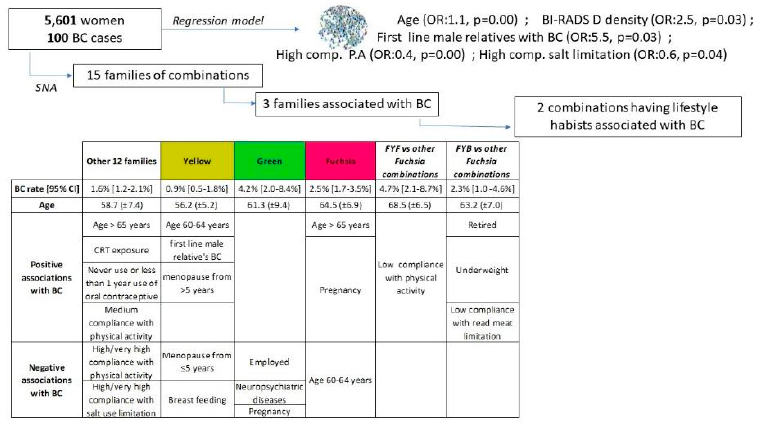
Figure 5. Graphical overview of the main results.